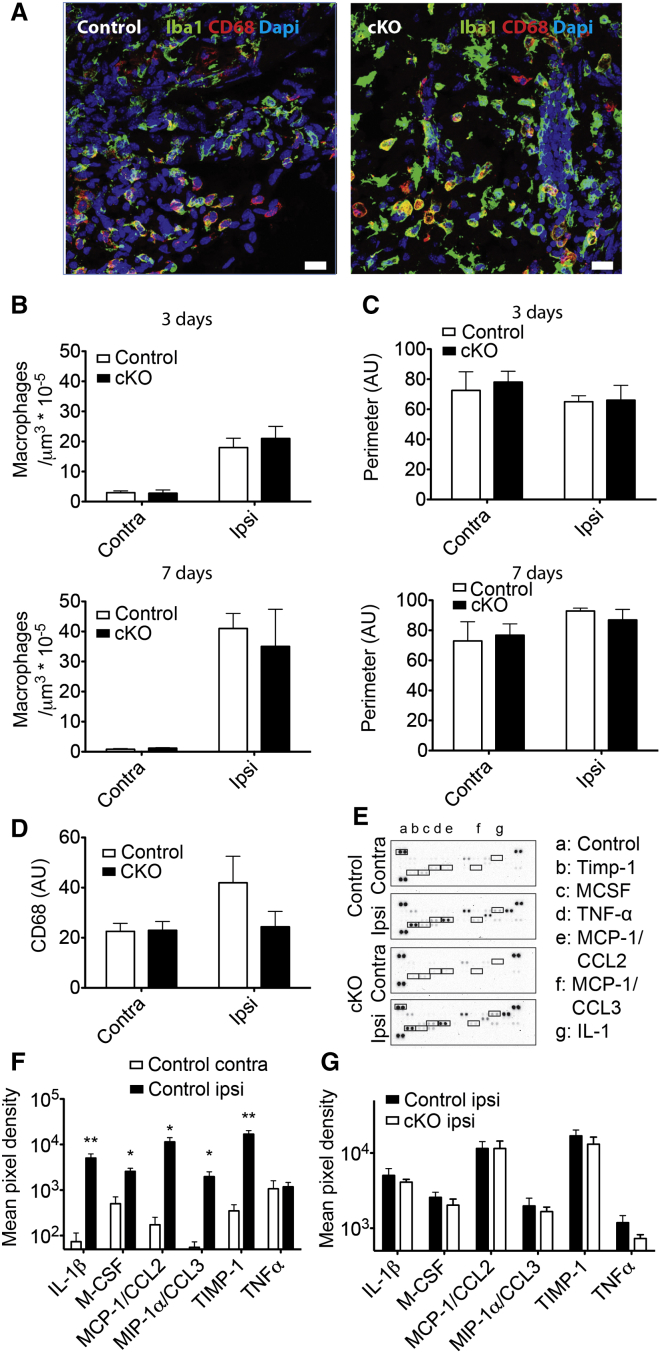
Histological and Biochemical Analysis of Macrophages Recruited at the Nerve Injury(A) Iba1 (red), CD68 (green), and DAPI (blue) immunofluorescence in the ipsilateral nerve cryosections from control and cKO mice, 7 days after injury. Scale bar, 20 μm.(B) Density of Iba1 positive macrophages at the distal side of the nerve injury at 3 and 7 days after injury. n = 3, p < 0.05.(C) Size of Iba1 positive macrophages on the distal side of the nerve injury at 3 and 7 days after injury; n = 3; p < 0.05.(D) CD68 intensity in Iba1 positive macrophages, 7 days after PNL; n = 3; p > 0.05.(E) Cytokine/chemokine array blots incubated with contralateral and ipsilateral sciatic nerve extracts (130 μg) from control and cKO mice, 4 days after injury.(F) Pixel densities of selected cytokine spots in the contralateral and ipsilateral sciatic nerve lysates from control mice. p < 0.05, p < 0.01. n = 3 sets of pooled samples from four mice each.(G) Pixel densities of selected cytokine spots in the ipsilateral sciatic nerve lysates from control and cKO mice 4 days after injury, p > 0.05.Values are mean ± SEM.